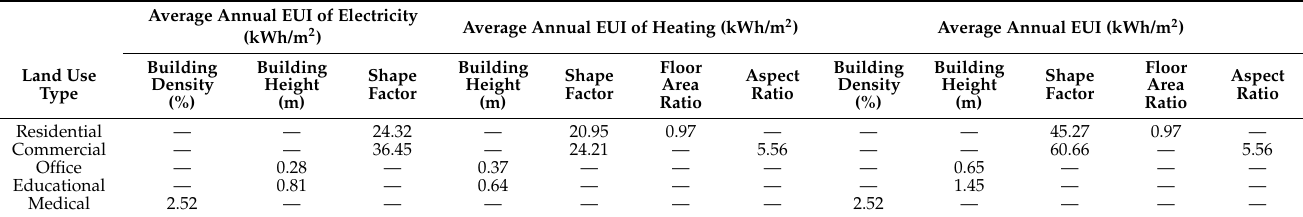
Table 13. Simulation EUI of urban morphology